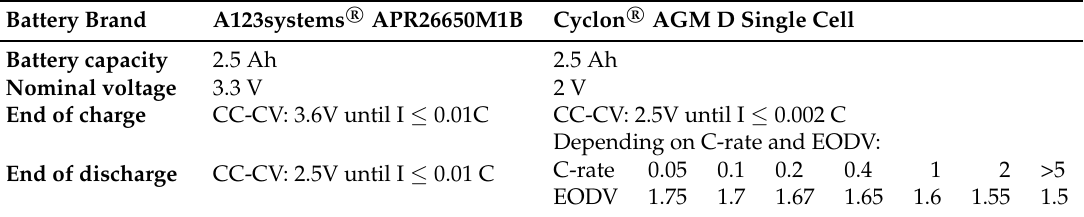
Table 1. Specification and summarized charge/discharge method for both battery technologies. Battery Brand